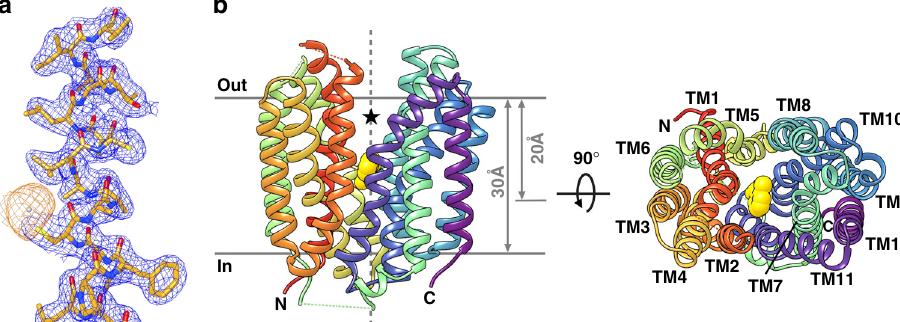
Fig. 2 Electron density and overall structure of SfMCT. a Electron density map from the SfMCT crystal structure. A view of the fi nal 2 F o -F c electron density map of TM12 of SfMCT (colored in blue and contoured at 1.5 σ ) is shown. The anomalous difference electron density (contoured at 3 σ ) of one Hg atom is shown in orange. The SfMCT structure is displayed as stick model. b Overall structure of SfMCT in the outward-open conformation viewed in the plane of the membrane (left) and from the periplasm (right). One molecule of bound thiosalicylate is shown in yellow as space- fi lling model. The asterisk highlights the central, conical cavity that is open to the periplasmic side and the dark grey, vertical broken line the pseudo-twofold symmetry axis of SfMCT. The N- and C-termini are labeled. Parts of the termini and of the loops connecting TM1 and TM2, TM5 and TM6 as well as TM6 and TM7 could not be traced and are indicated by broken lines. Models are colored based on rainbow coloring